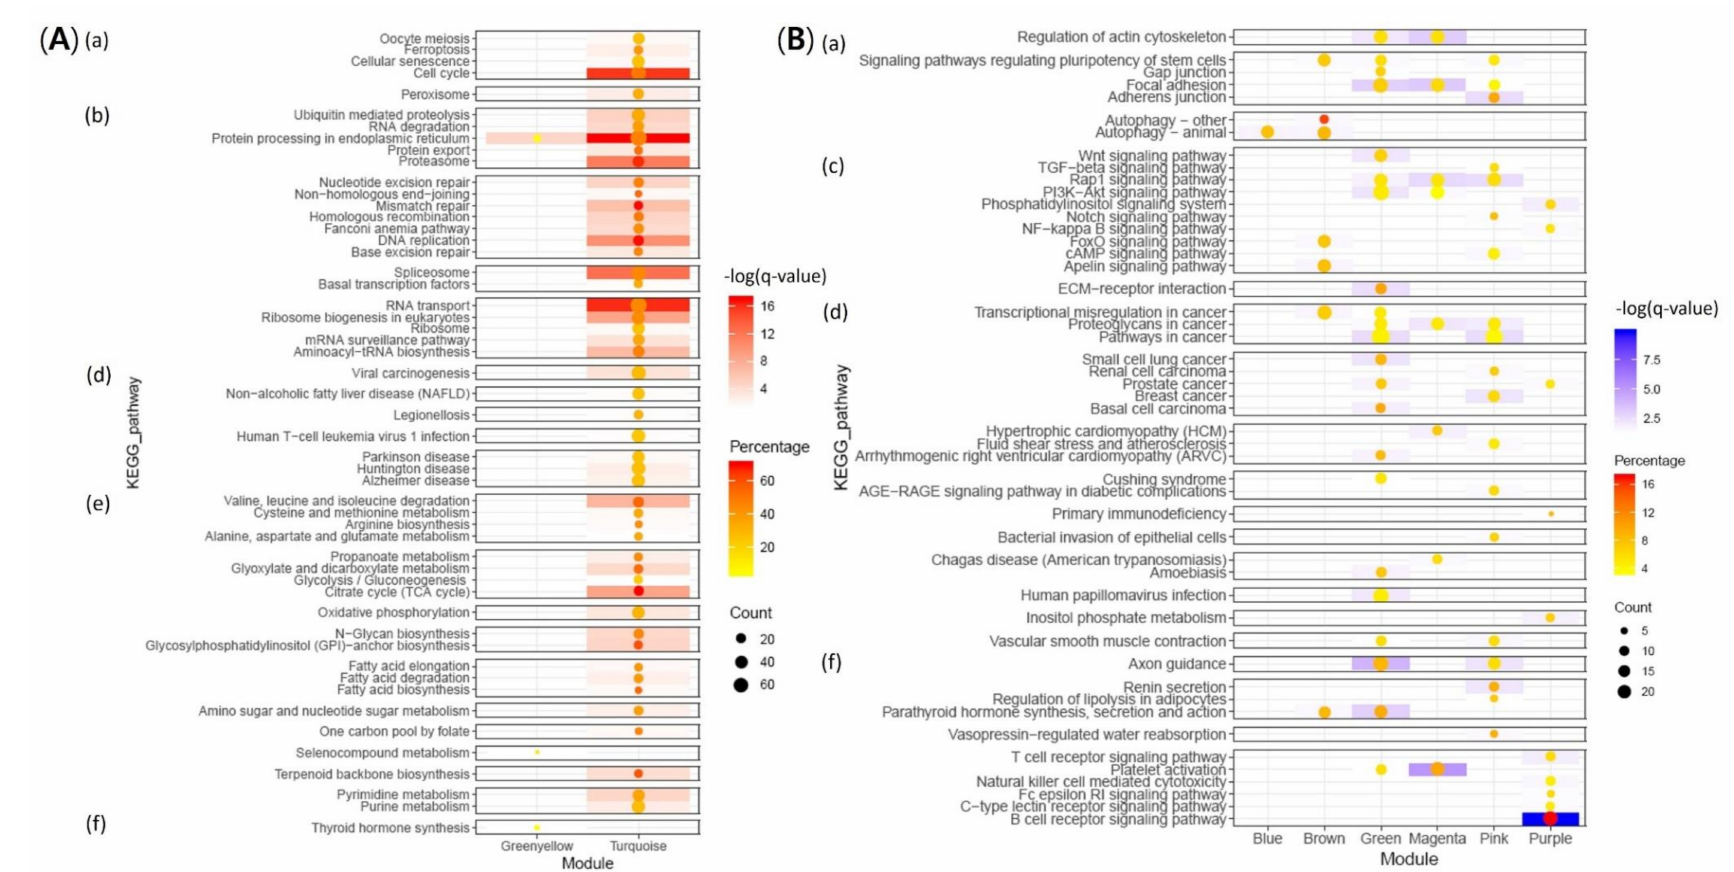
Figure 3. Visualization of all results from KEGG over-representation analysis of positive ( A ) and negative ( B ) modules ( q -value < 0.05) performed by consensuspathDB. Box color represents the significance level (that is, deeper color means more significant). Circle size and color intensity in box represent the number of genes and percentage mapped in the pathway, respectively. Top categories in KEGG orthology (KO): (a) cellular processes, (b) genetic information processing c) environmental information processing, (d) human diseases, (e) metabolism, and (f) only immune systems in organismal